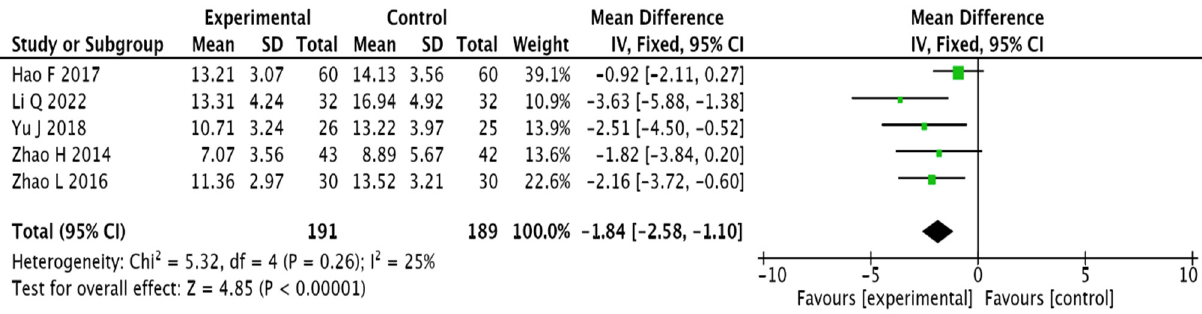
Figure 7. Forest plot of TCM symptom score.